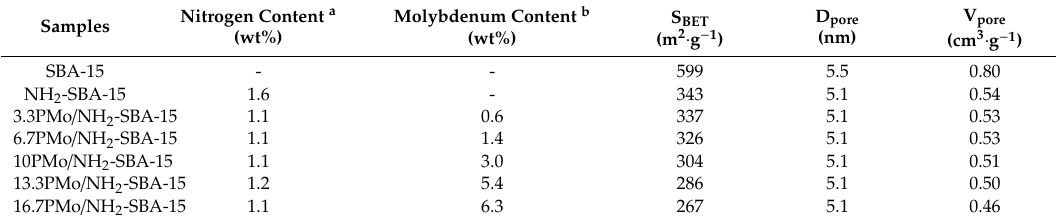
Table 1. Textural properties of SBA-15, NH 2 -SBA-15 and xPMo / NH 2 -SBA-15.